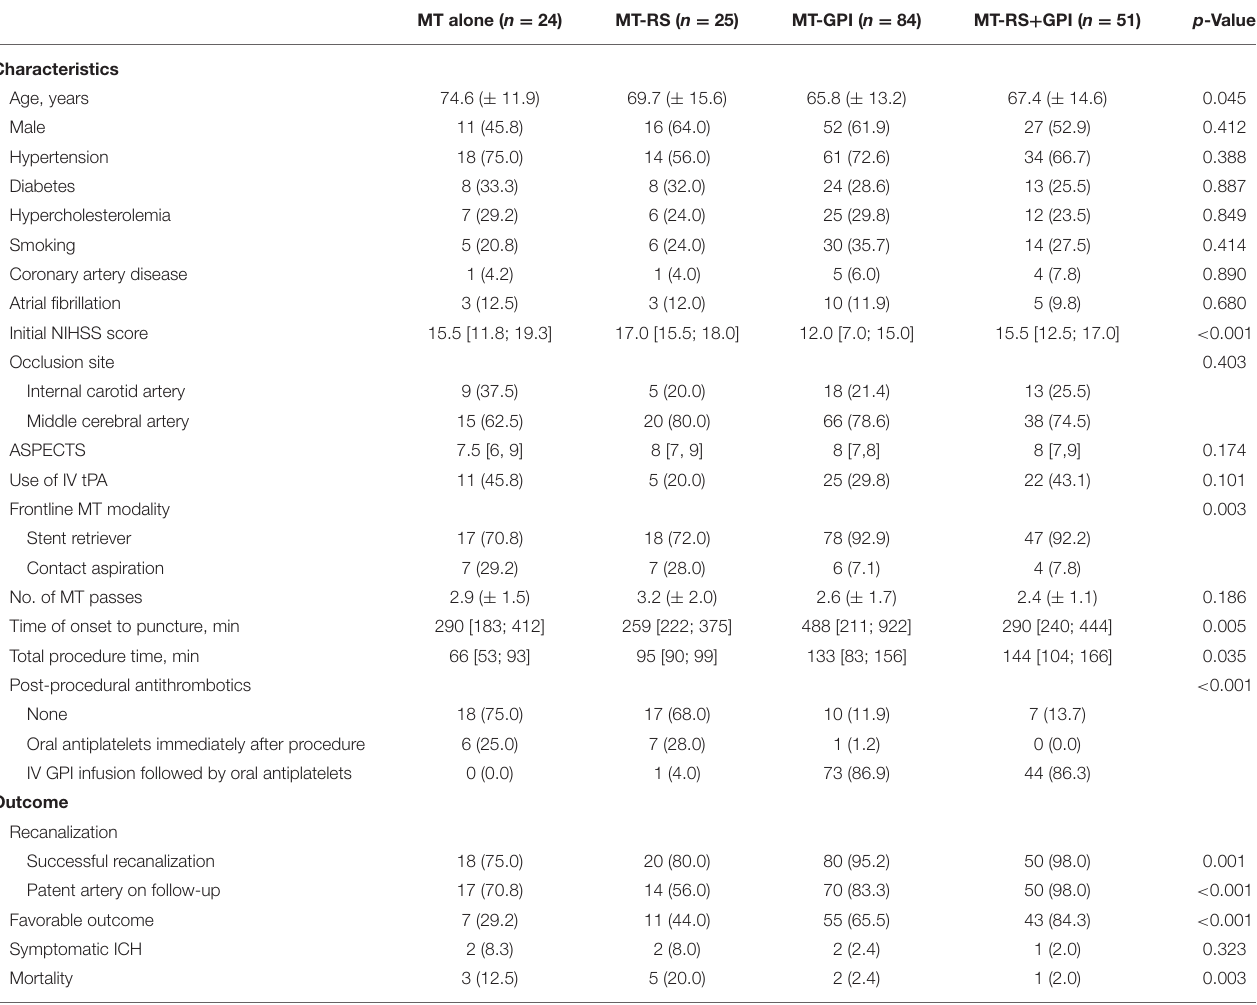
TABLE 1 | Clinical and procedural characteristics and outcomes based on endovascular modality for intracranial atherosclerosis-related large-vessel occlusion. MT alone ( n = 24) MT-RS ( n = 25) MT-GPI ( n = 84) MT-RS + GPI ( n =